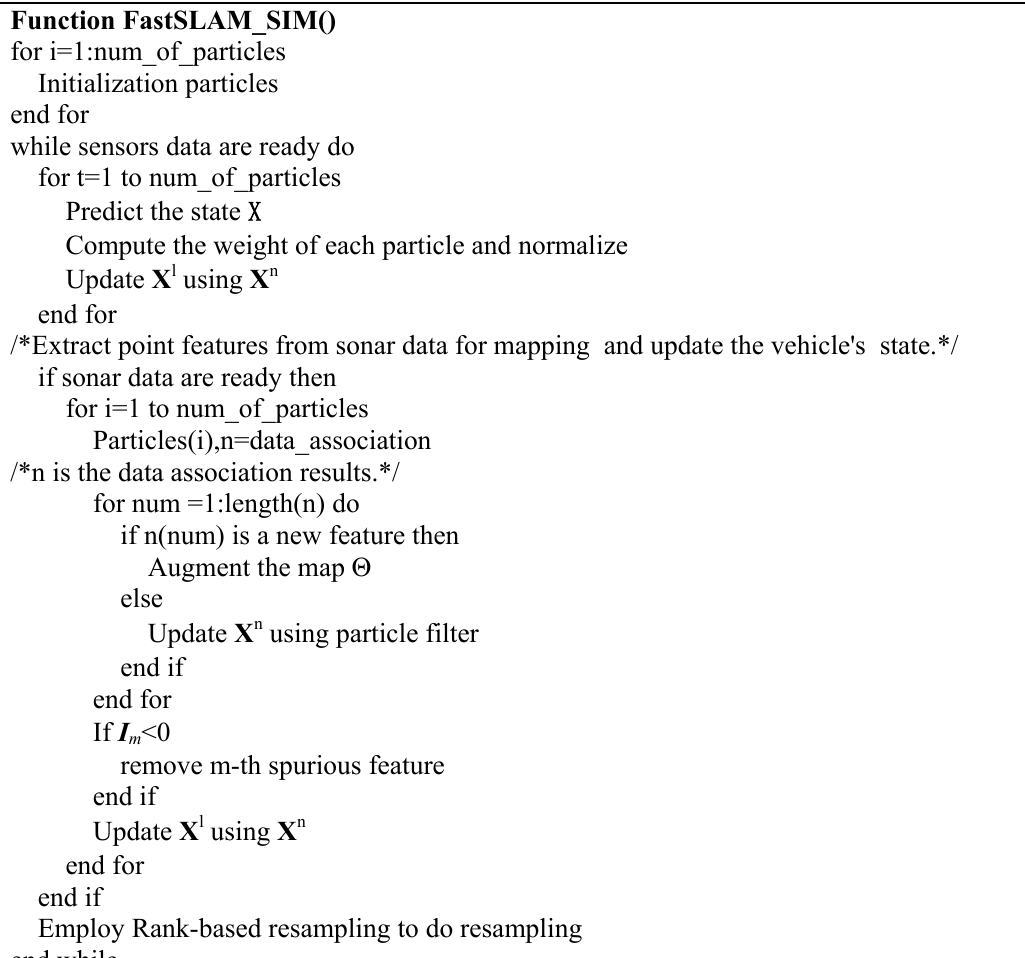
Table 3. The SLAM algorithm in the C-Ranger